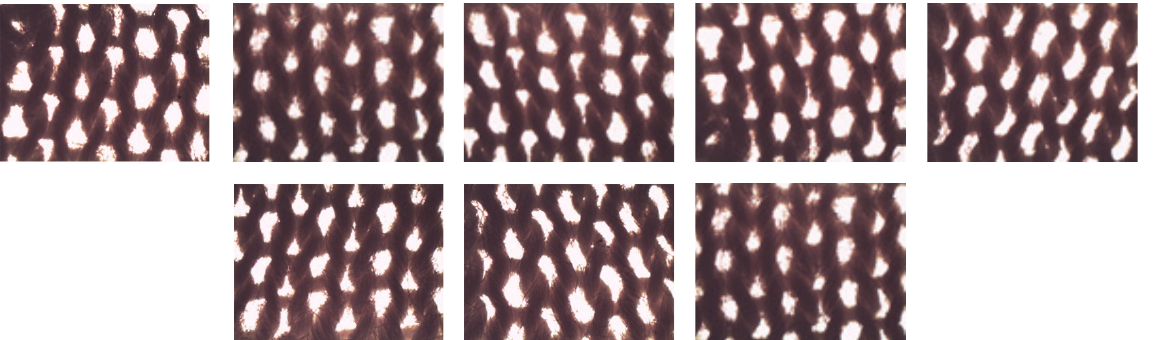
Figure 4: Macroscopic view of the 8 single-jersey knitted samples from